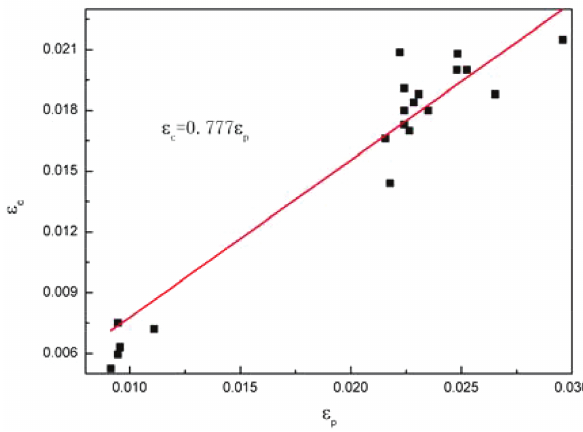
Figure 10: The relationship between ε c and ε p